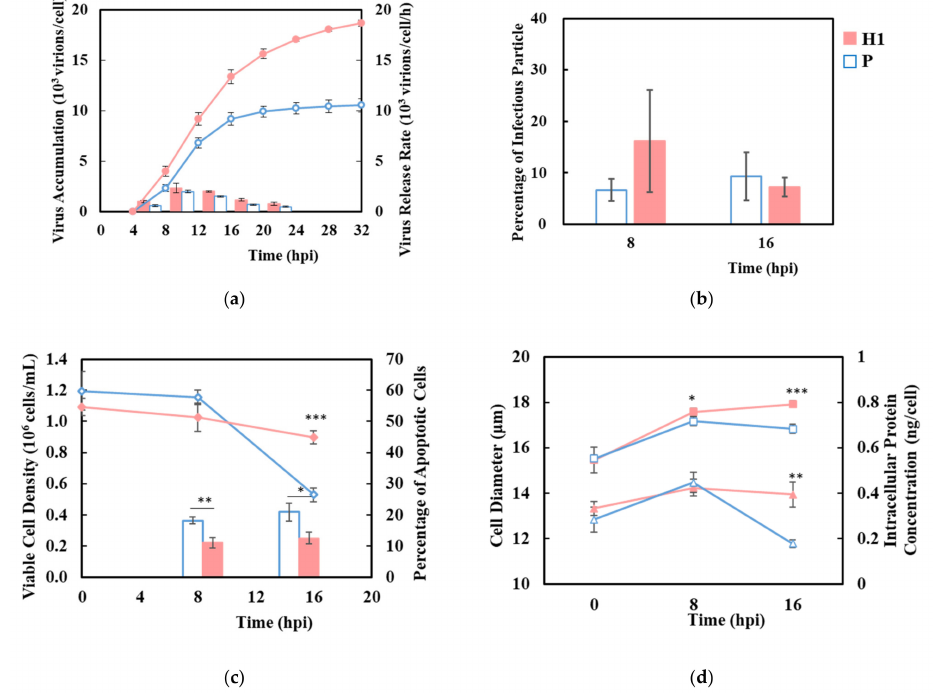
Figure 2. Sustained viability and higher virus production during a synchronized single-cycle infection of influenza A virus in H1 compared to P. ( a ) virus accumulation (circle) and virus release rate (bar), ( b ) percentage of infectious virus to total virions. ( c ) viable cell density (diamond) and percentage of apoptotic cells (bar). ( d ) cell diameter (square) and intracellular protein concentration (triangle). Solid red: H1, hollow blue: P. Experiments were done in triplicated infections. * p < 0.05, ** p < 0.01, *** p <